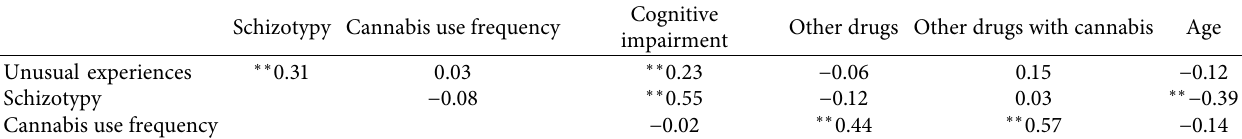
Table 2: Spearman’s rho correlation coefficients between the ordinal variables within the study.